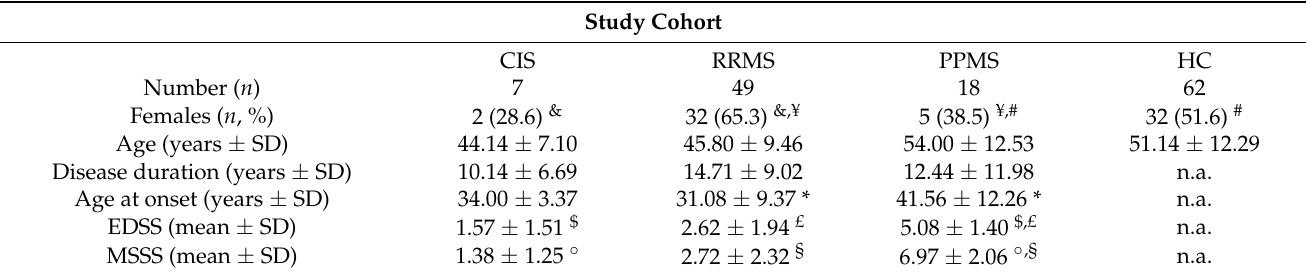
Table 1. Study cohort demographic and clinical characteristics. Study